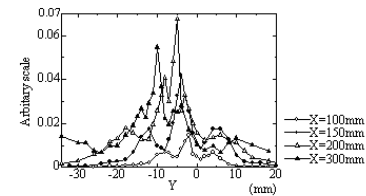
Fig. 15 Amplitude distribution of second harmonics (14Hz